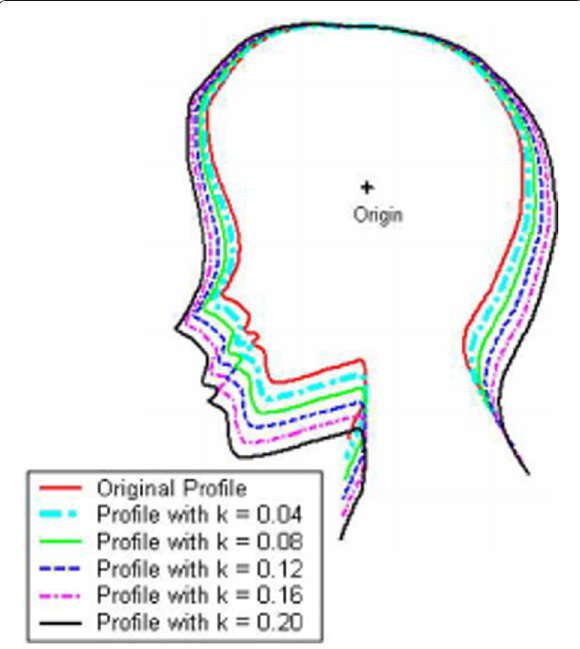
Fig. 3 Simulation of facial growth using cardioidal strain transformations. The original is shown in [213]. Sequence proceeds from infancy (innermost profile) to adulthood (outermost